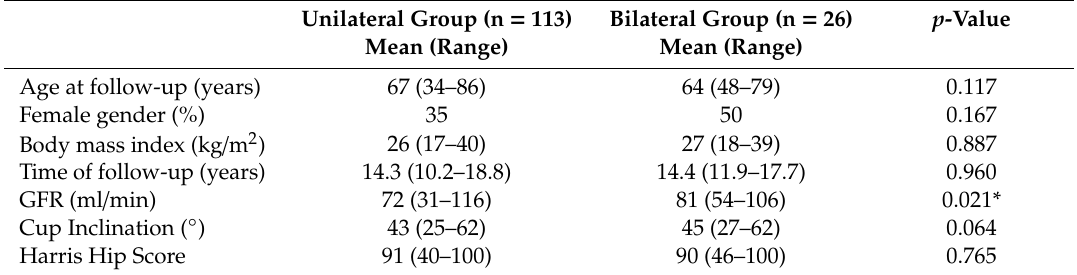
Table 1. Demographic data of the unilateral and bilateral group for metal ion analysis.